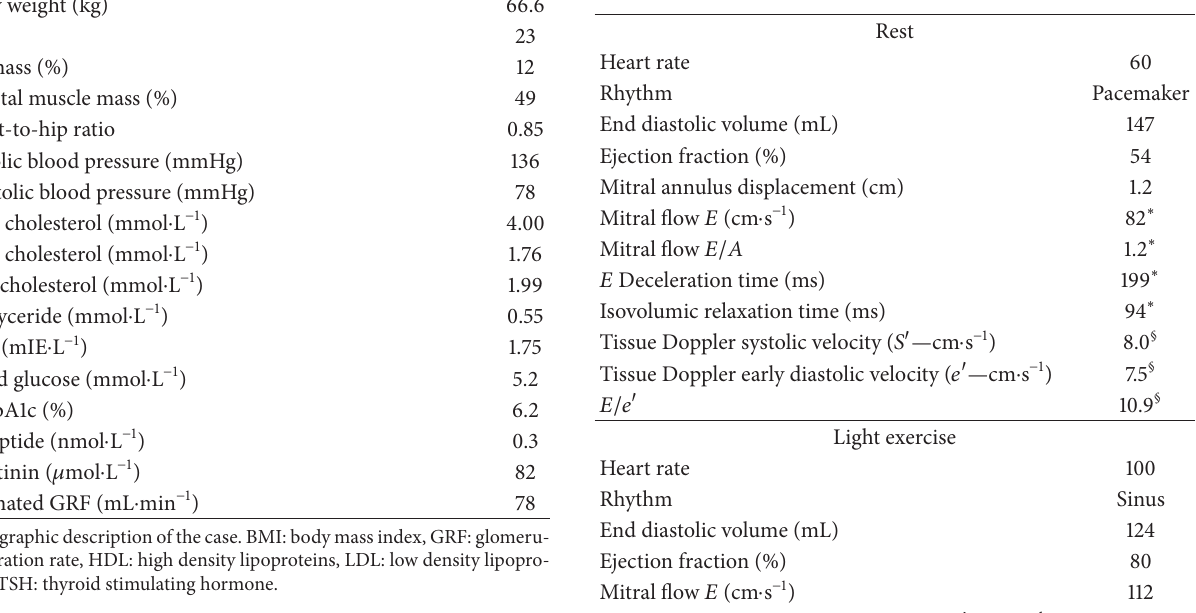
Table 1: Demographic variables. Table 2: Cardiac findings at rest and light exercise with echocardio-